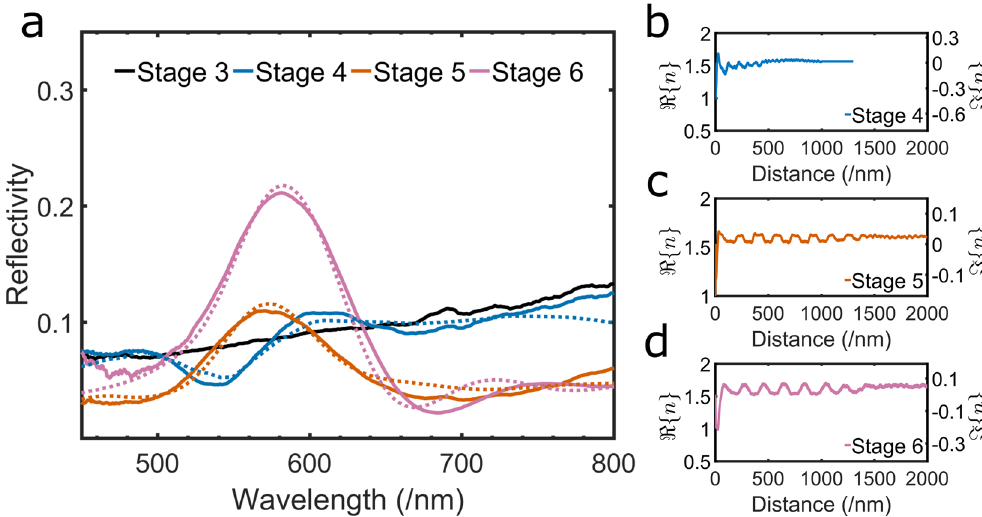
Figure 5. ( a ) The experimental spectra collected from a 10 μ m spot (solid lines) compared to the spectral response as predicted by the transfer-matrix simulations (dashed lines). ( b – d ) The real part and imaginary part of the refractive index as a function of the cuticle’s depth at different stages of development of the cuticle, see